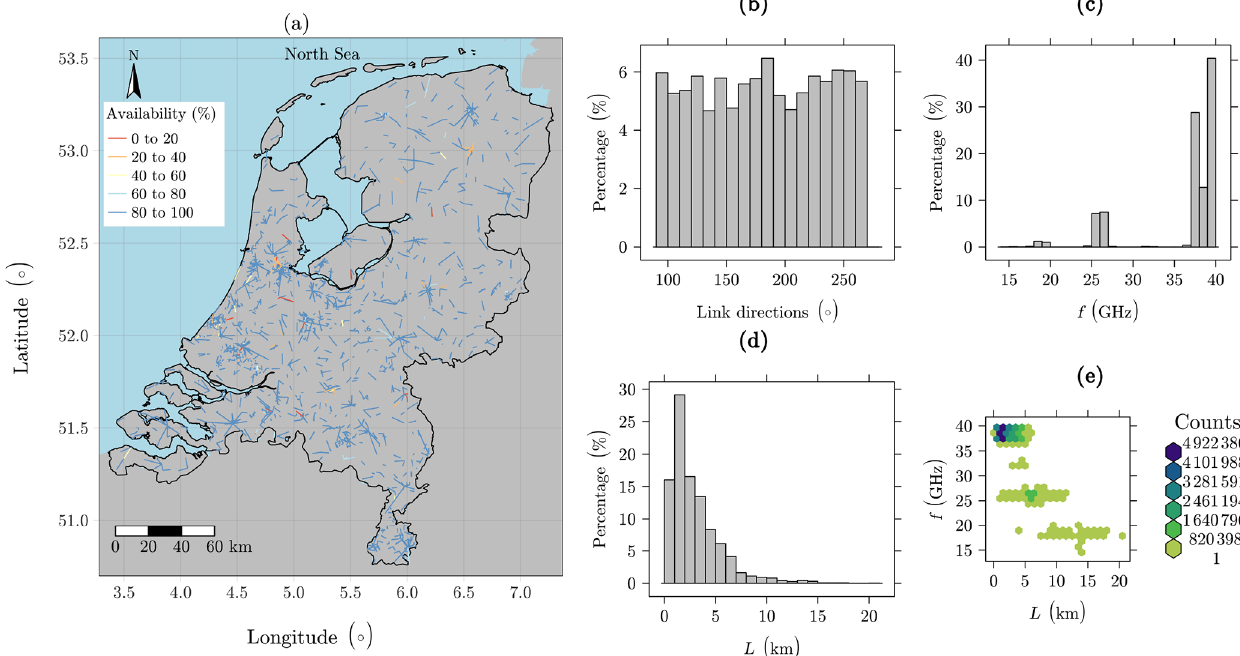
Figure 1. Map of the Netherlands and sub-link characteristics for the validation dataset: (a) CML locations and availability, (b) distribution of link directions, (c) distribution of microwave link frequencies, (d) distribution of link lengths, and (e) density of link length and frequency